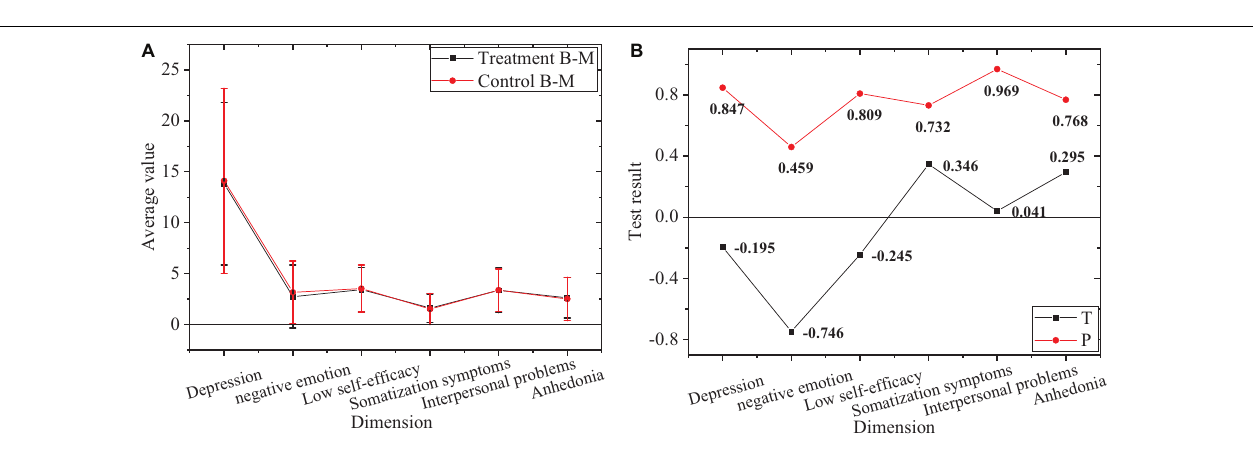
Frontiers in Psychology |